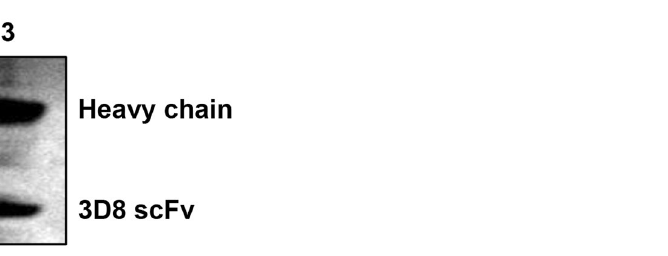
Figure 3. Western blot analysis of 3D8 scFv proteins in transgenic and non-transgenic CEFs. The 3D8 scFv gene was expressed in transgenic CEFs. A heavy chain was also detected in all samples because of the